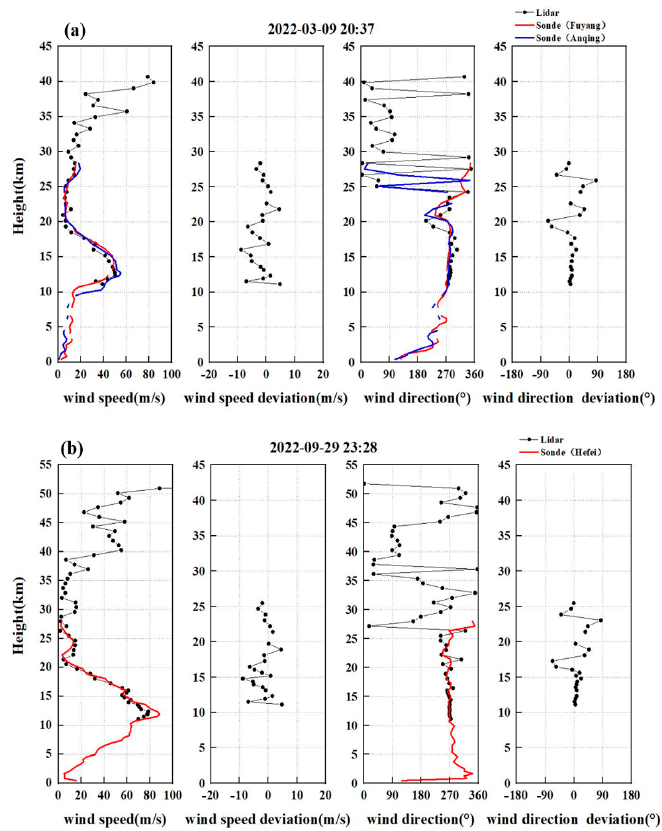
Figure 16. Comparison of Doppler wind Lidar and radio sounding instrument results. ( a ) Original ( b )